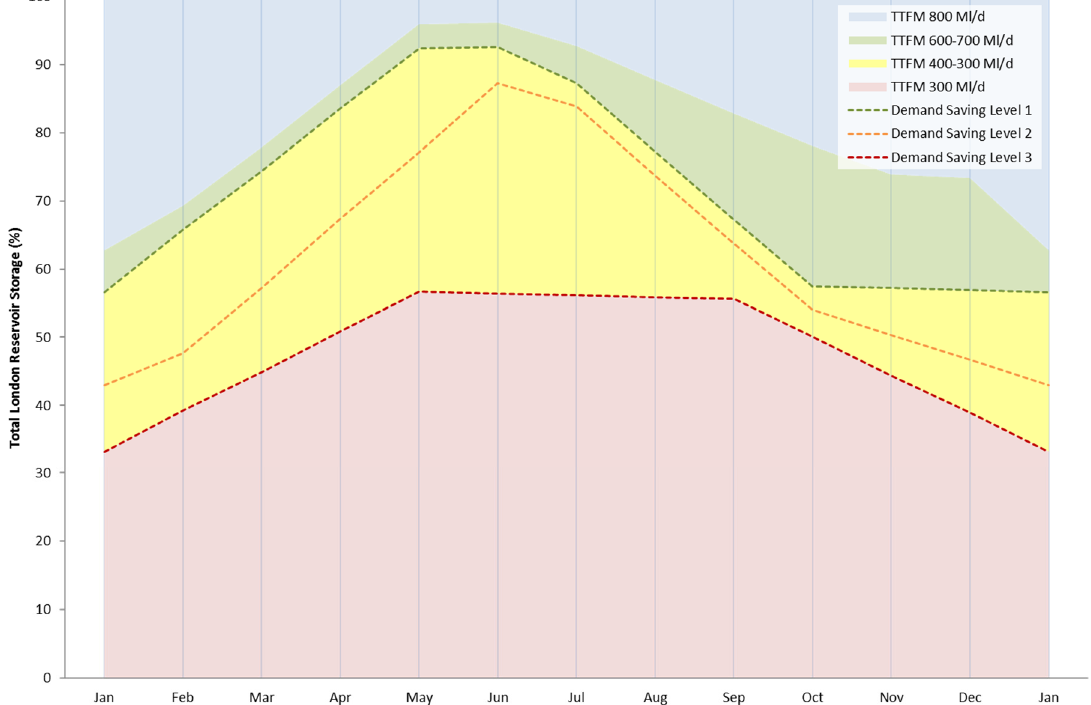
Figure 5. The most complex solution obtained for the LTCD with expanded storage of 6 Ml, which results in DO of 2335 Ml/day.